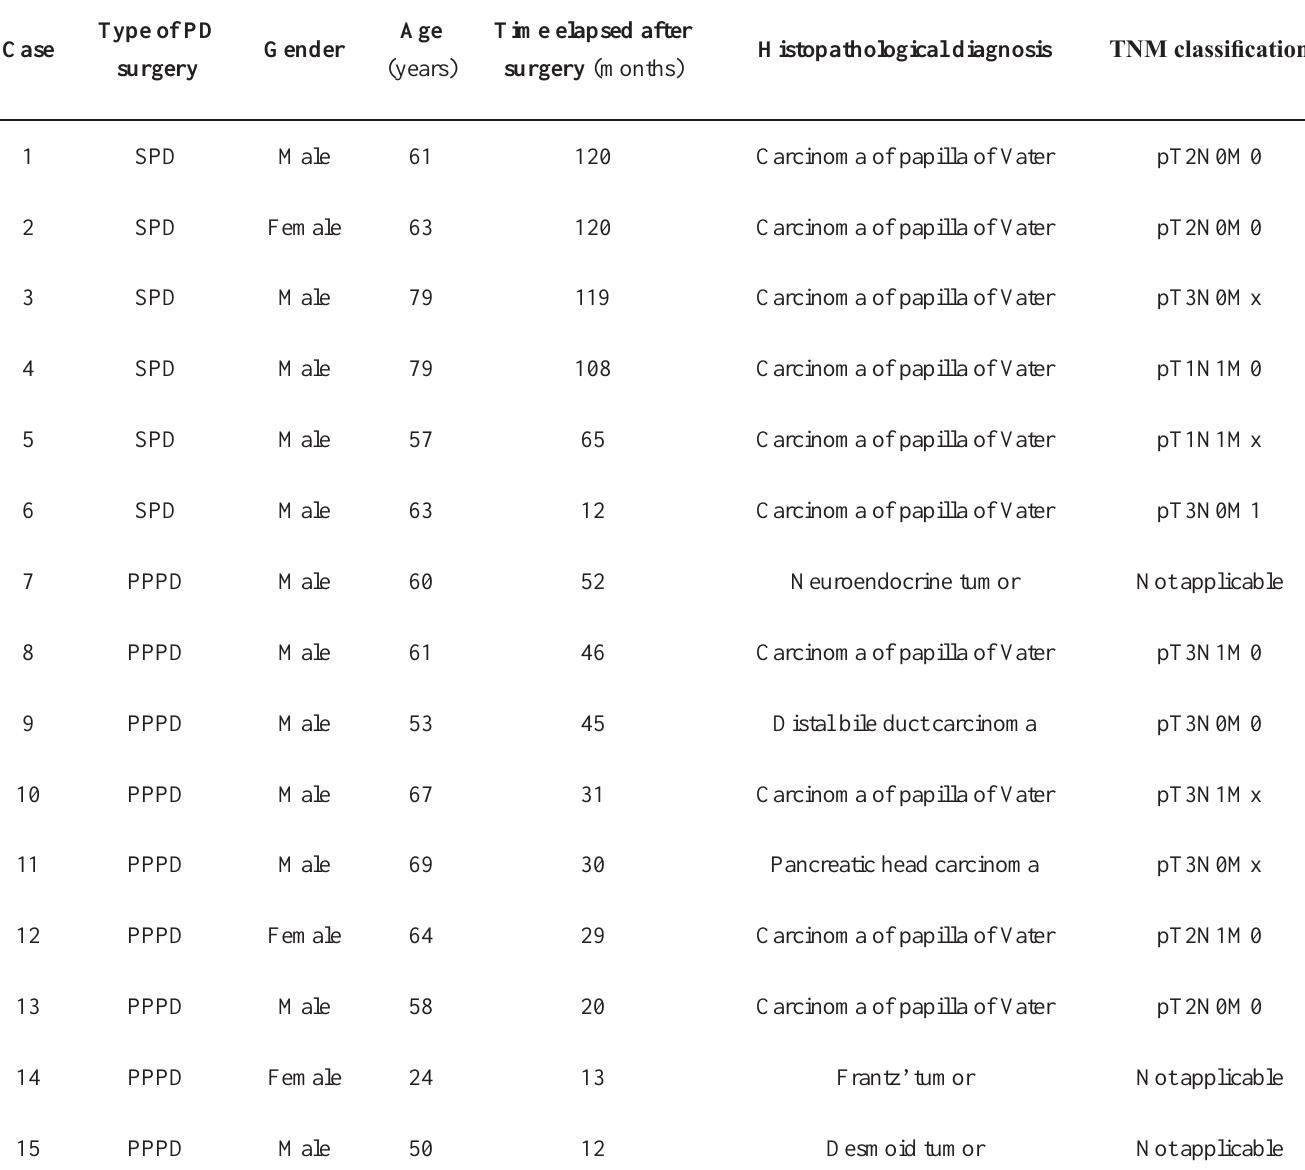
TABLE 1 - Demographic characteristics of patients who underwent PD surgery, time elapsed after surgery, histopathological diagnosis and TNM